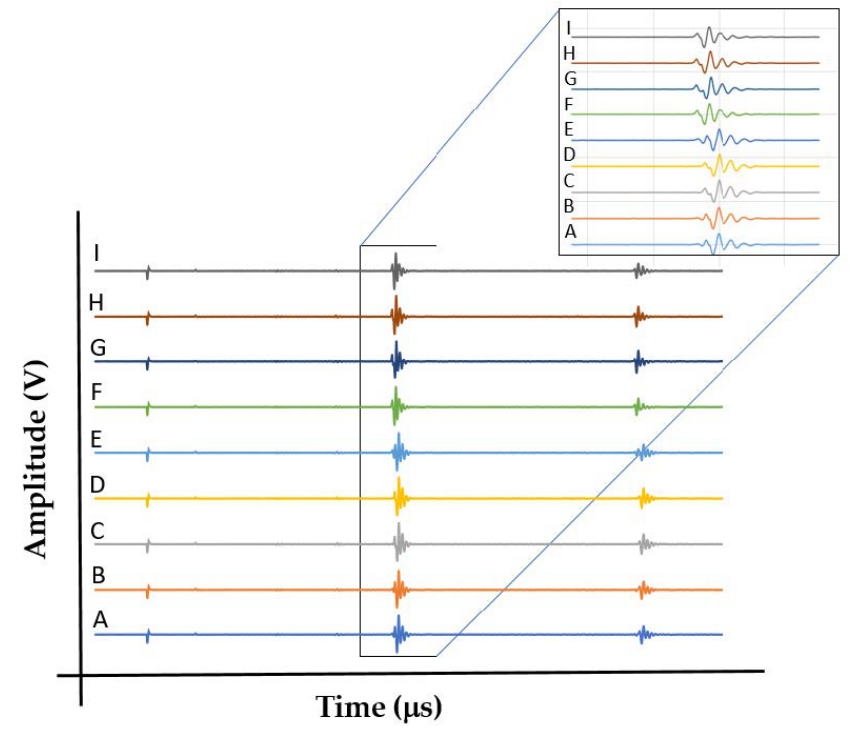
Figure 8. Nine shear SWVs at different angles (A–I) in the EBM sample. Zoom-in on the first echo reveals a small shit in the TOF.